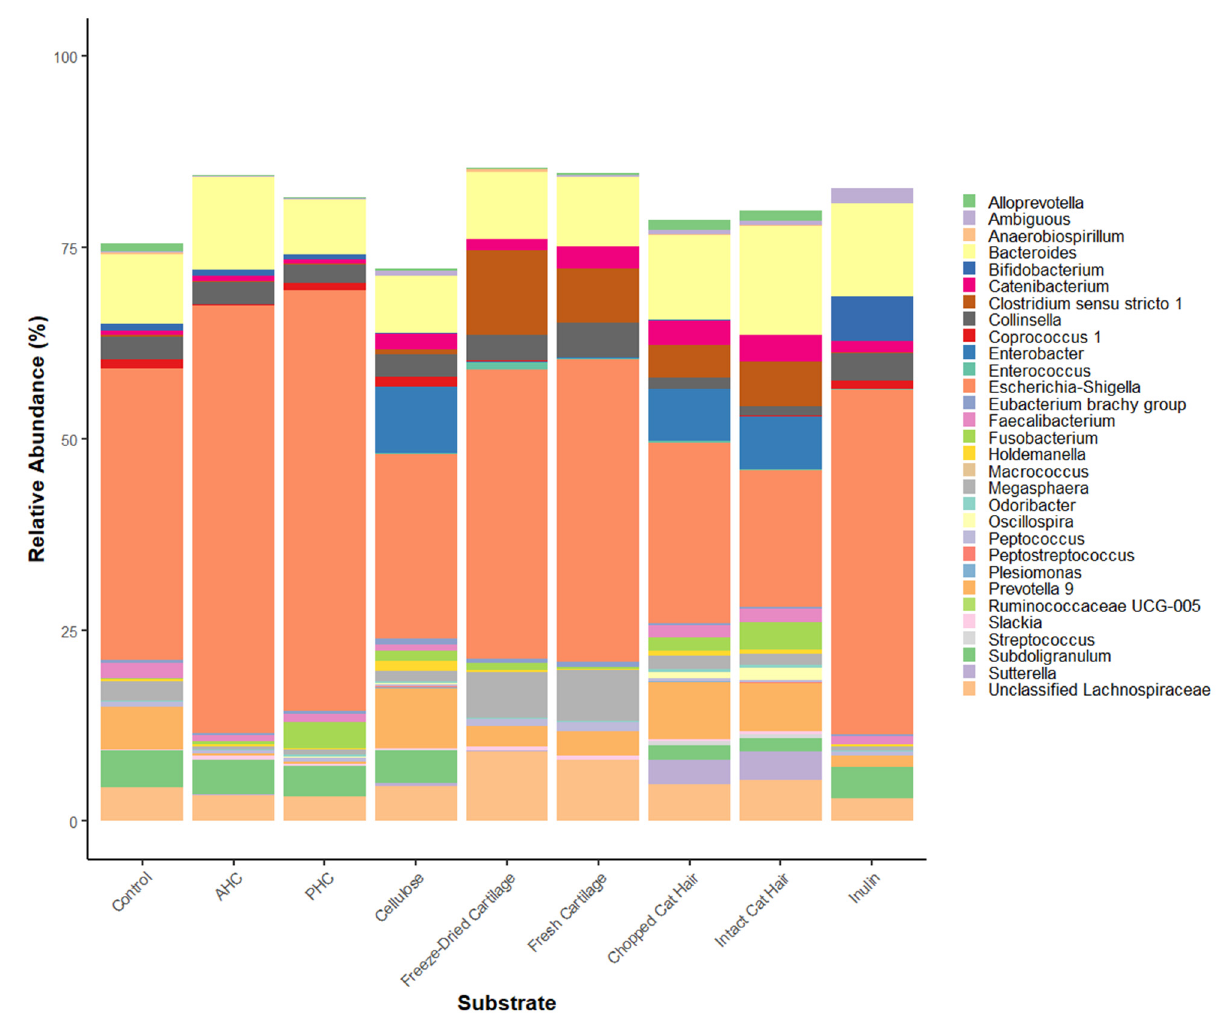
Figure 4. Barplot of the relative abundance of the top 30 bacterial genera present at 24 h in the in vitro fermentation system of the high carbohydrate faecal inoculum (CD) according to substrate. Each colour in the bar plot represents a bacterial genus, with the size of the bar denoting their relative abundance.